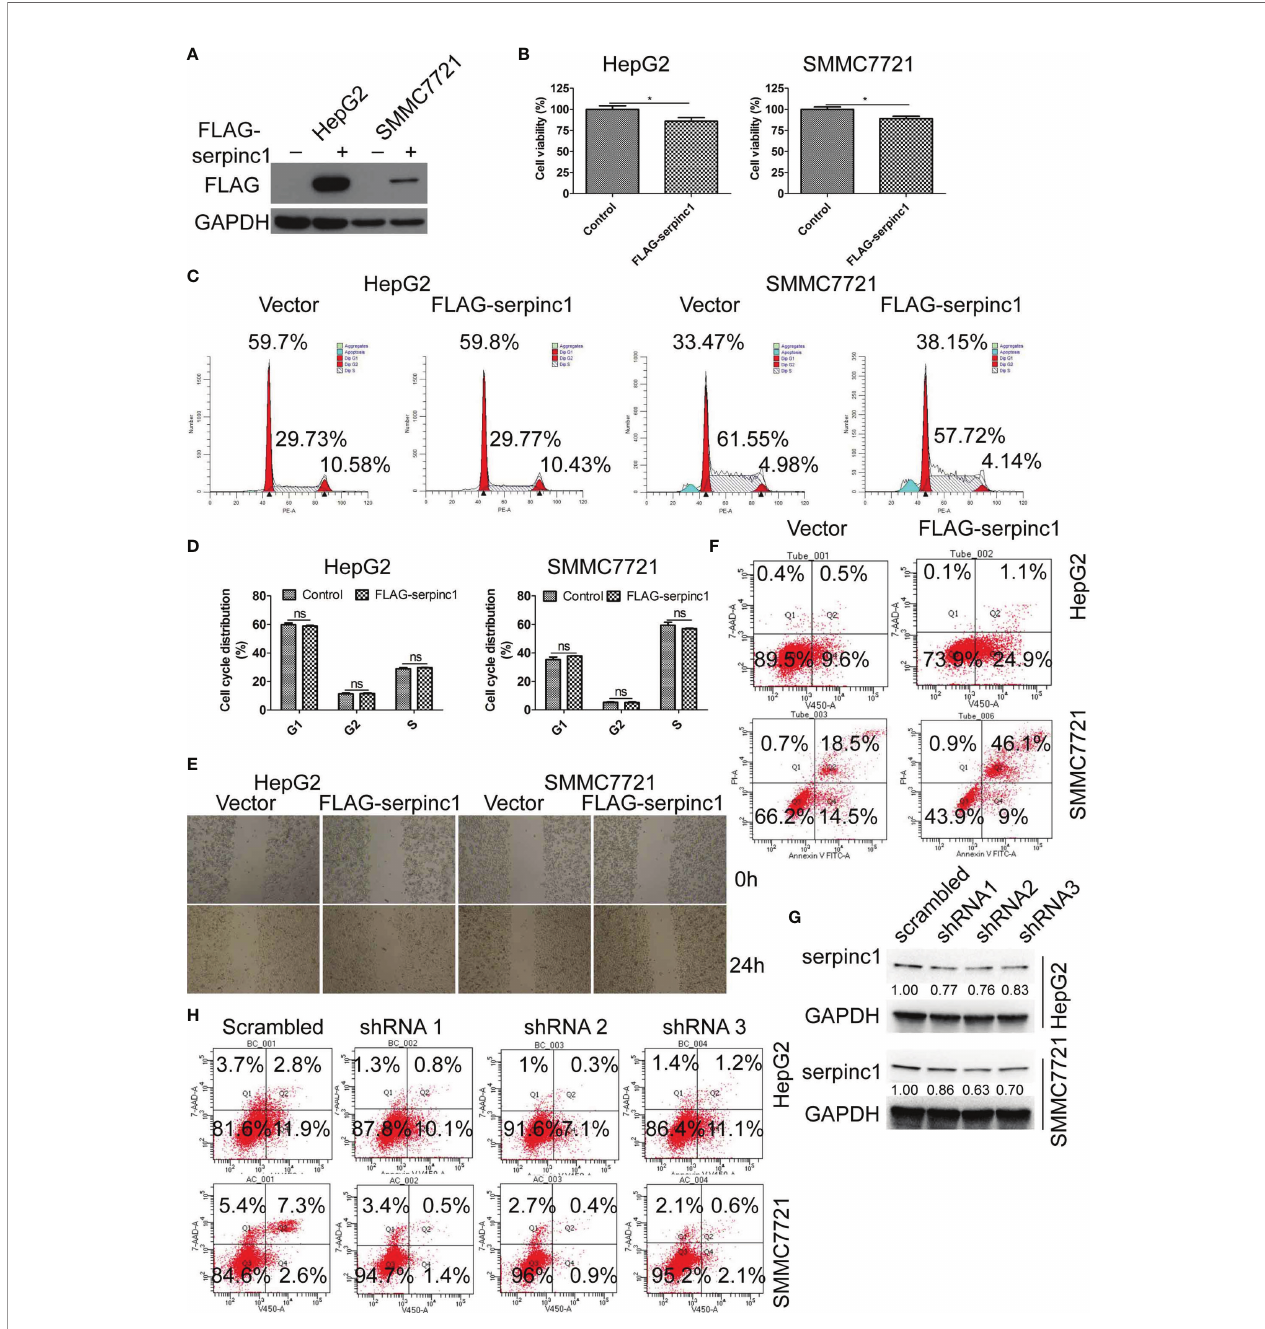
FIGURE 3 | Serpinc1 overexpression induced apoptosis in HepG2 and SMMC7721 cells. (A – F) HepG2 and SMMC7721 cells were overexpressed with control or serpinc1. (A) Western blot to detect the expression level of serpinc1. (B) MTS to detect the cell viability. (C, D) Detection of cell cycle distribution. Representative images (C) and statistical analysis (D) of cell cycle distribution. (E) Wound healing assay to analyze the migration of hepatocellular carcinoma cell lines. (F) Flow cytometry to analyze the apoptosis. (G, H) Scrambled or serpinc1 shRNA were transfected in HepG2 and SMMC7721 cells. The knockdown of serpinc1 was detected by western blot (G) , and the cell apoptosis was detected by fl ow cytometry (H) . * P < 0.05, ns, no signi fi cant, P >